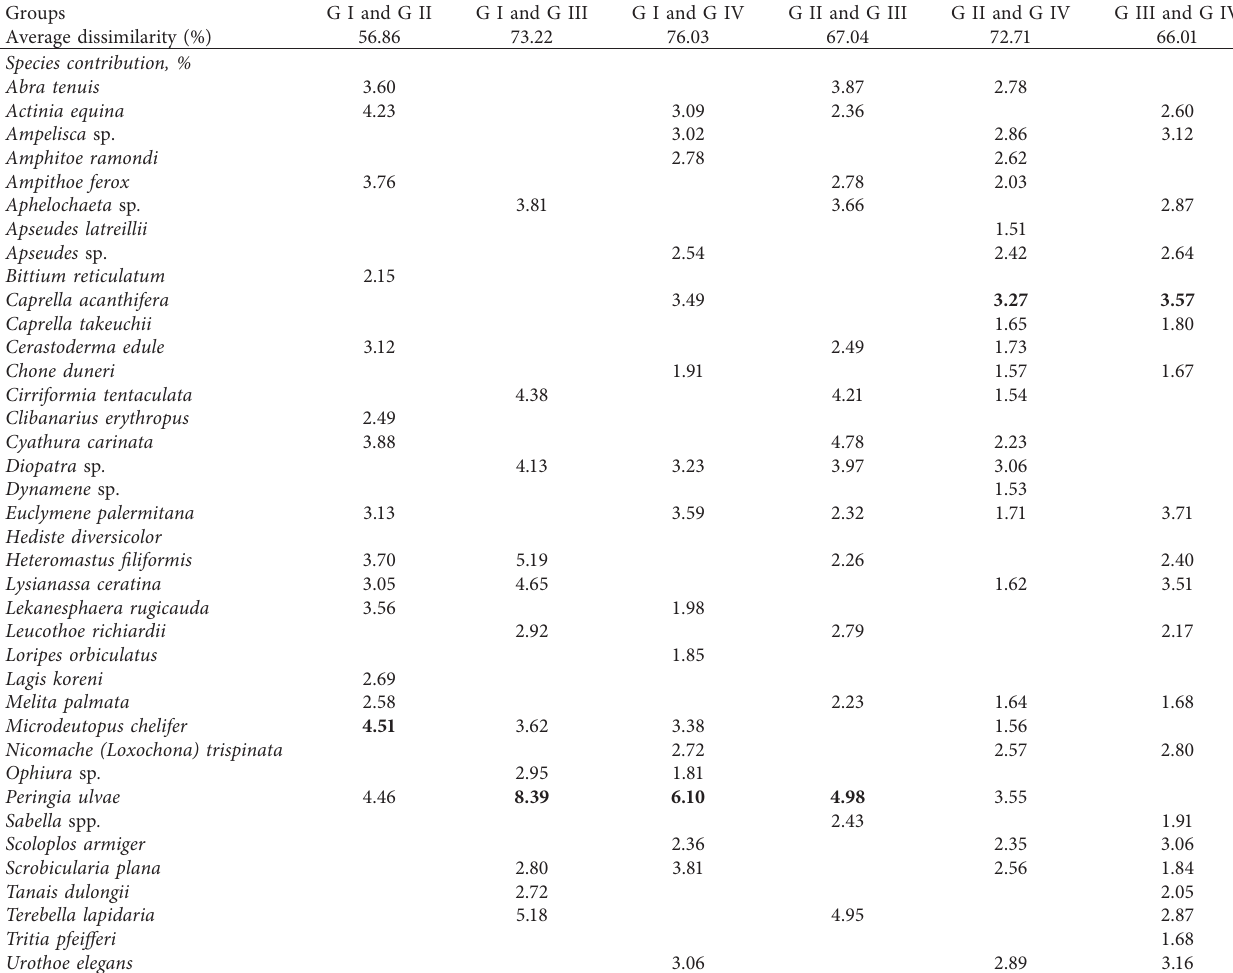
Table 7: Results of SIMPER analysis showing the average dissimilarity between the different benthic assemblages. Assemblages were identified by the hierarchical ascendant classification analysis and the species contributing in the dissimilarity of each benthic assemblage (cutoff 50%).